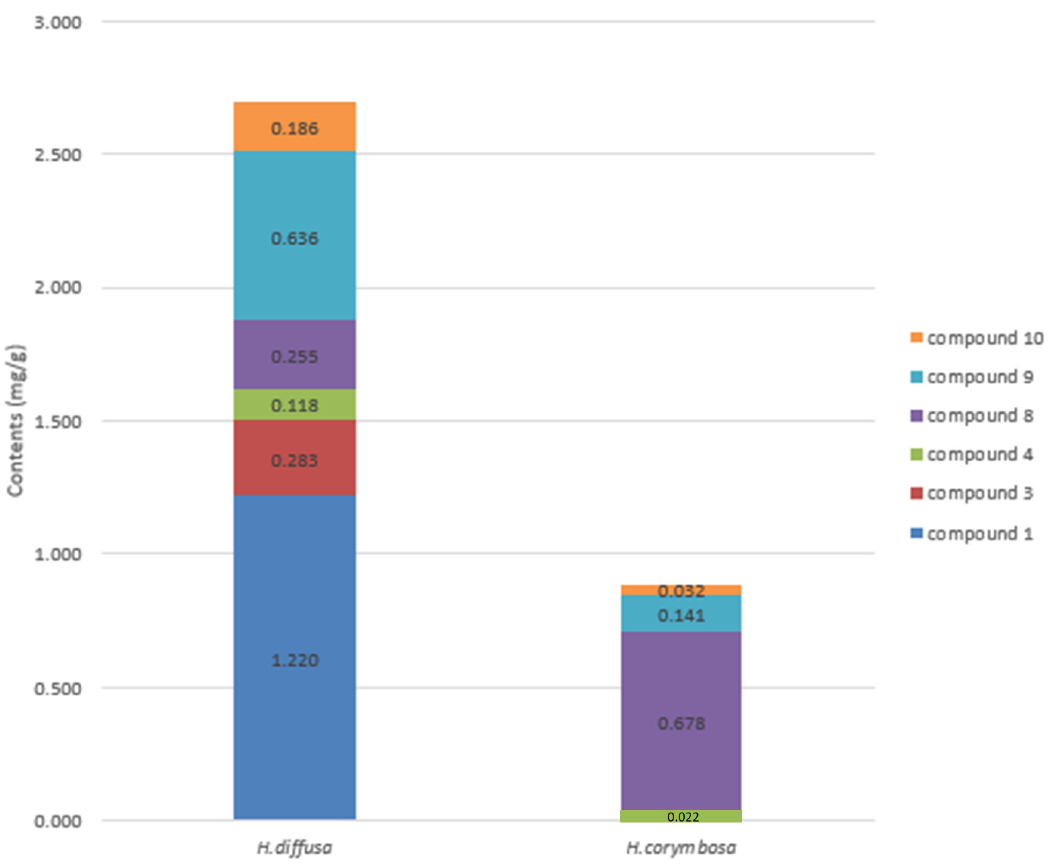
Figure 4. Quantity of major components in Hedyotis di ff usa and Hedyotis corymbosa